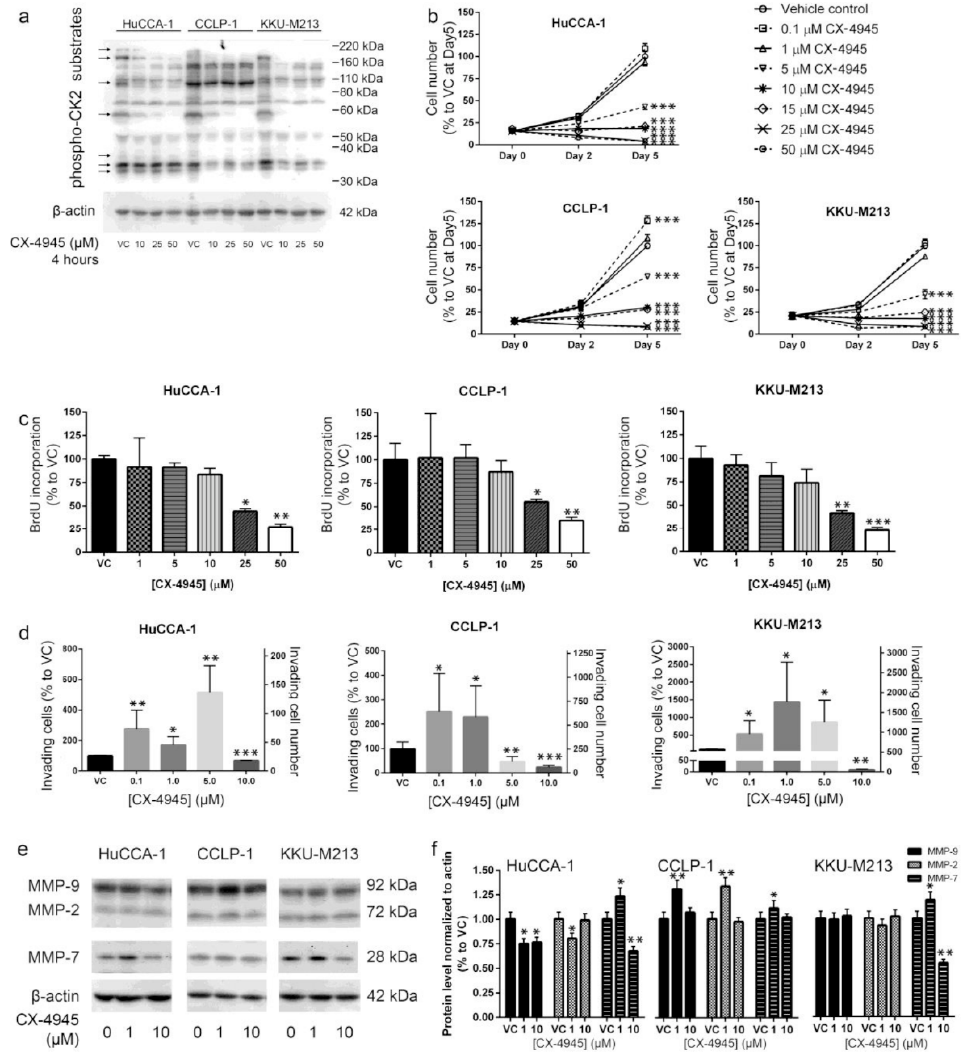
Figure 1. The effects of CX-4945 on cholangiocarcinoma (CCA) cell lines. ( a ) CX-4945 (Silmitasertib) inhibited CK2 (previously casein kinase II) activity in a dose-dependent manner. Arrows indicate CK2 phospho-substrates that decrease in intensity with CX-4945 treatment. ( b ) CX-4945 at 5 µ M and higher doses reduced CCA cell number in three CCA cell lines as determined using MTT assays. ( c ) CX-4945 at 25 and 50 µ M inhibited CCA cell lines proliferation in a 5-bromo-2 (cid:48) -deoxyuridine (BrdU) incorporation assay 24 h post-treatment. ( d ) CX-4945 exerted a biphasic effect on cell invasion through Matrigel. CX-4945 at 5 µ M or lower doses induced invasion by HuCCA-1 cells and KKU-M213 cells while CX-4945 at 10 µ M inhibited CCA cell invasion through Matrigel. ( e ) Twenty-four hours’ post-treatment of CX-4945 at low doses upregulated matrix metallopeptidase 7 (MMP-7) level while 10 µ M CX-4945 downregulated MMP-7 level. MMP-2 and MMP-9 levels were not altered. ( f ) Quantitative data of protein level changes post treatment of CX-4945 in panel ( e ). VC; vehicle control, *; p < 0.05, **; p < 0.01, ***; p < 0.001. All experiments were performed in triplicate and with at least at three biological replicates. Graphs were plotted as mean ±